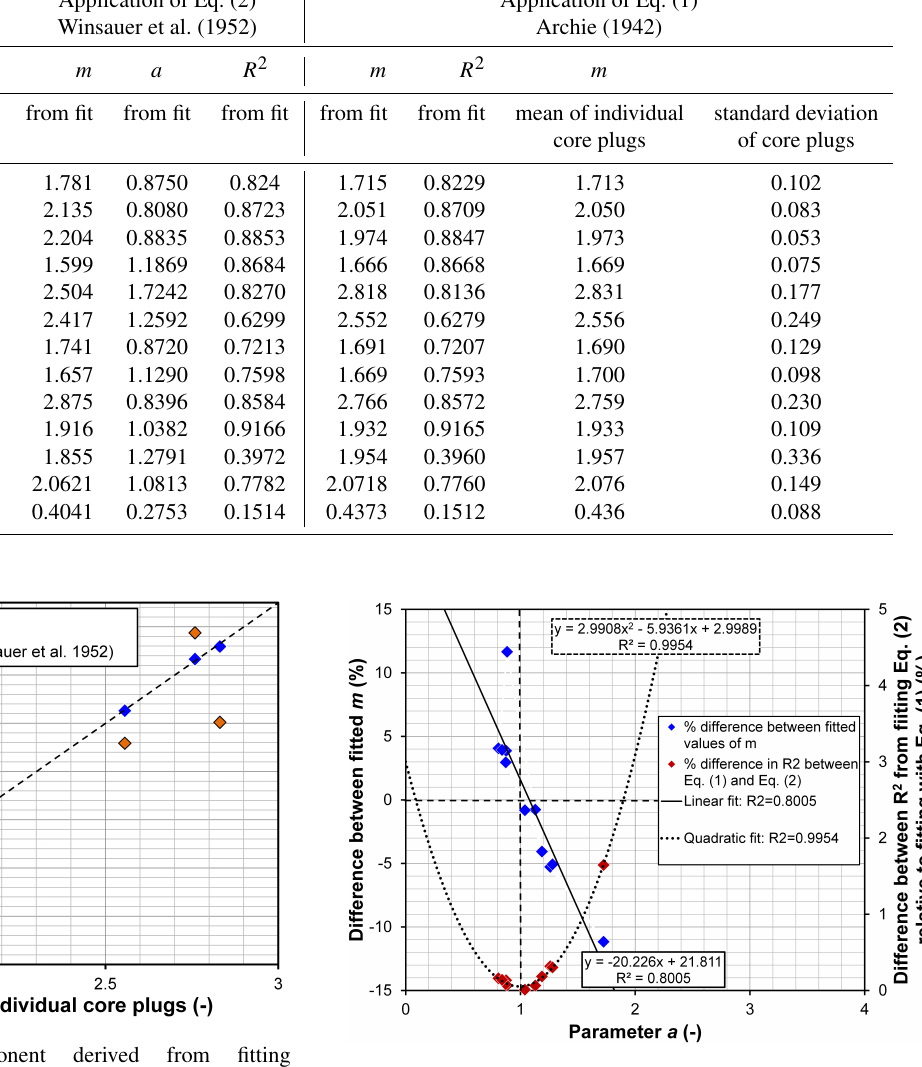
fitting Eq. (1) to the whole dataset is m = 2.072 ± 0.437,